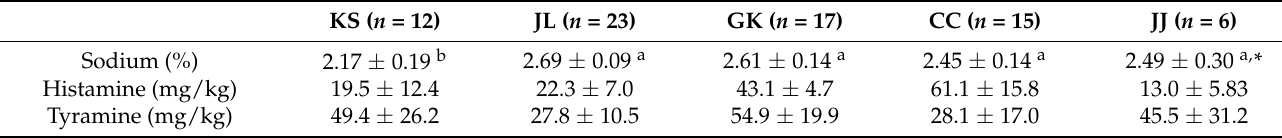
Table 1. Histamine, tyramine, and sodium contents in traditionally made Kochujang (TMK) samples from different areas of